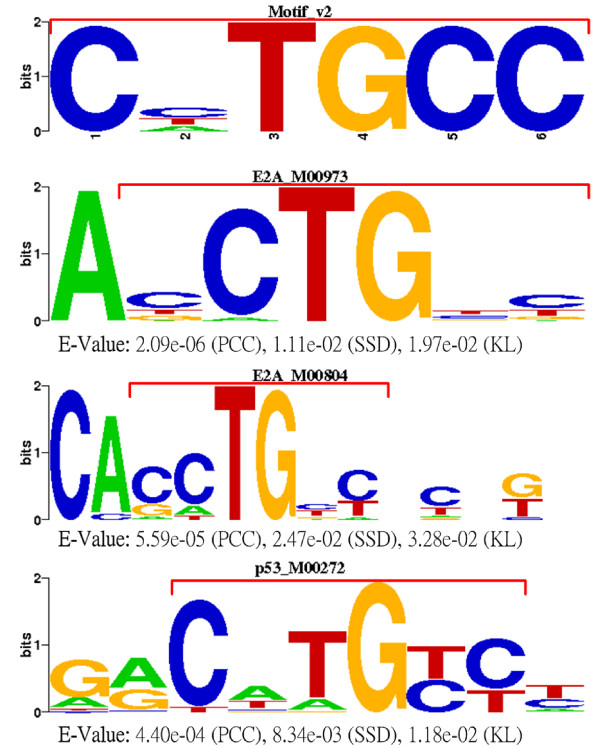
TFBS matches of the MyoD dataset. The matches from TRANSFAC to the 2nd motif output by GALF-G on the MyoD dataset. The red brackets indicate the aligned blocks.